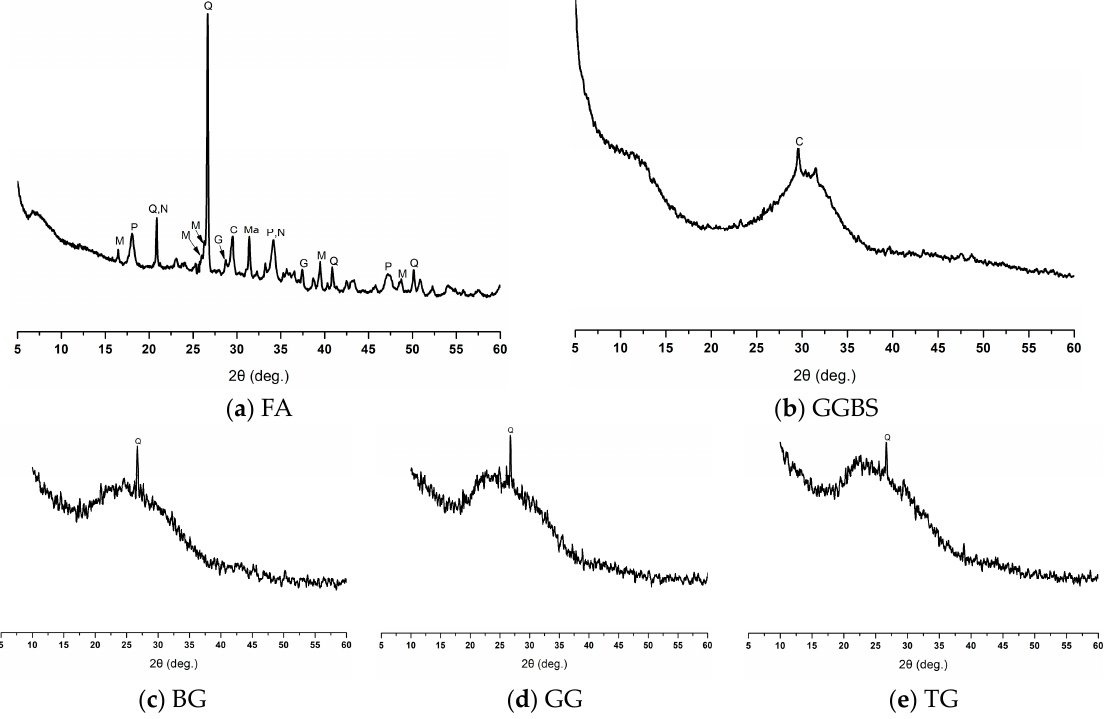
Figure 9. XRD patterns of precursors; ( a ) FA, ( b ) GGBS and three colored WGP; ( c ) Brown glass (BG); ( d ) Green glass (GG); ( e ) Transparent glass (TG). Note: Q = quartz (00-046-1045 > SiO 2 ), M = mullite (00-015-0776 > Al 6 Si 2 O 13 ), Ma = magnetite (01-079-0418 > Fe 3 O 4 ), C = calcite (01-071-3699 > CaCO 3 ), P = Portlandite (00-004-0733 > Ca(OH) 2 ), N = sodium magnesium aluminum silicate (00-047-1498 > Na 1.74 MgO 0.79 Al 0.15 Si 1.0604 ), G = gehlenite (00-035-0755 > Ca 2 Al 2 SiO 7 ).